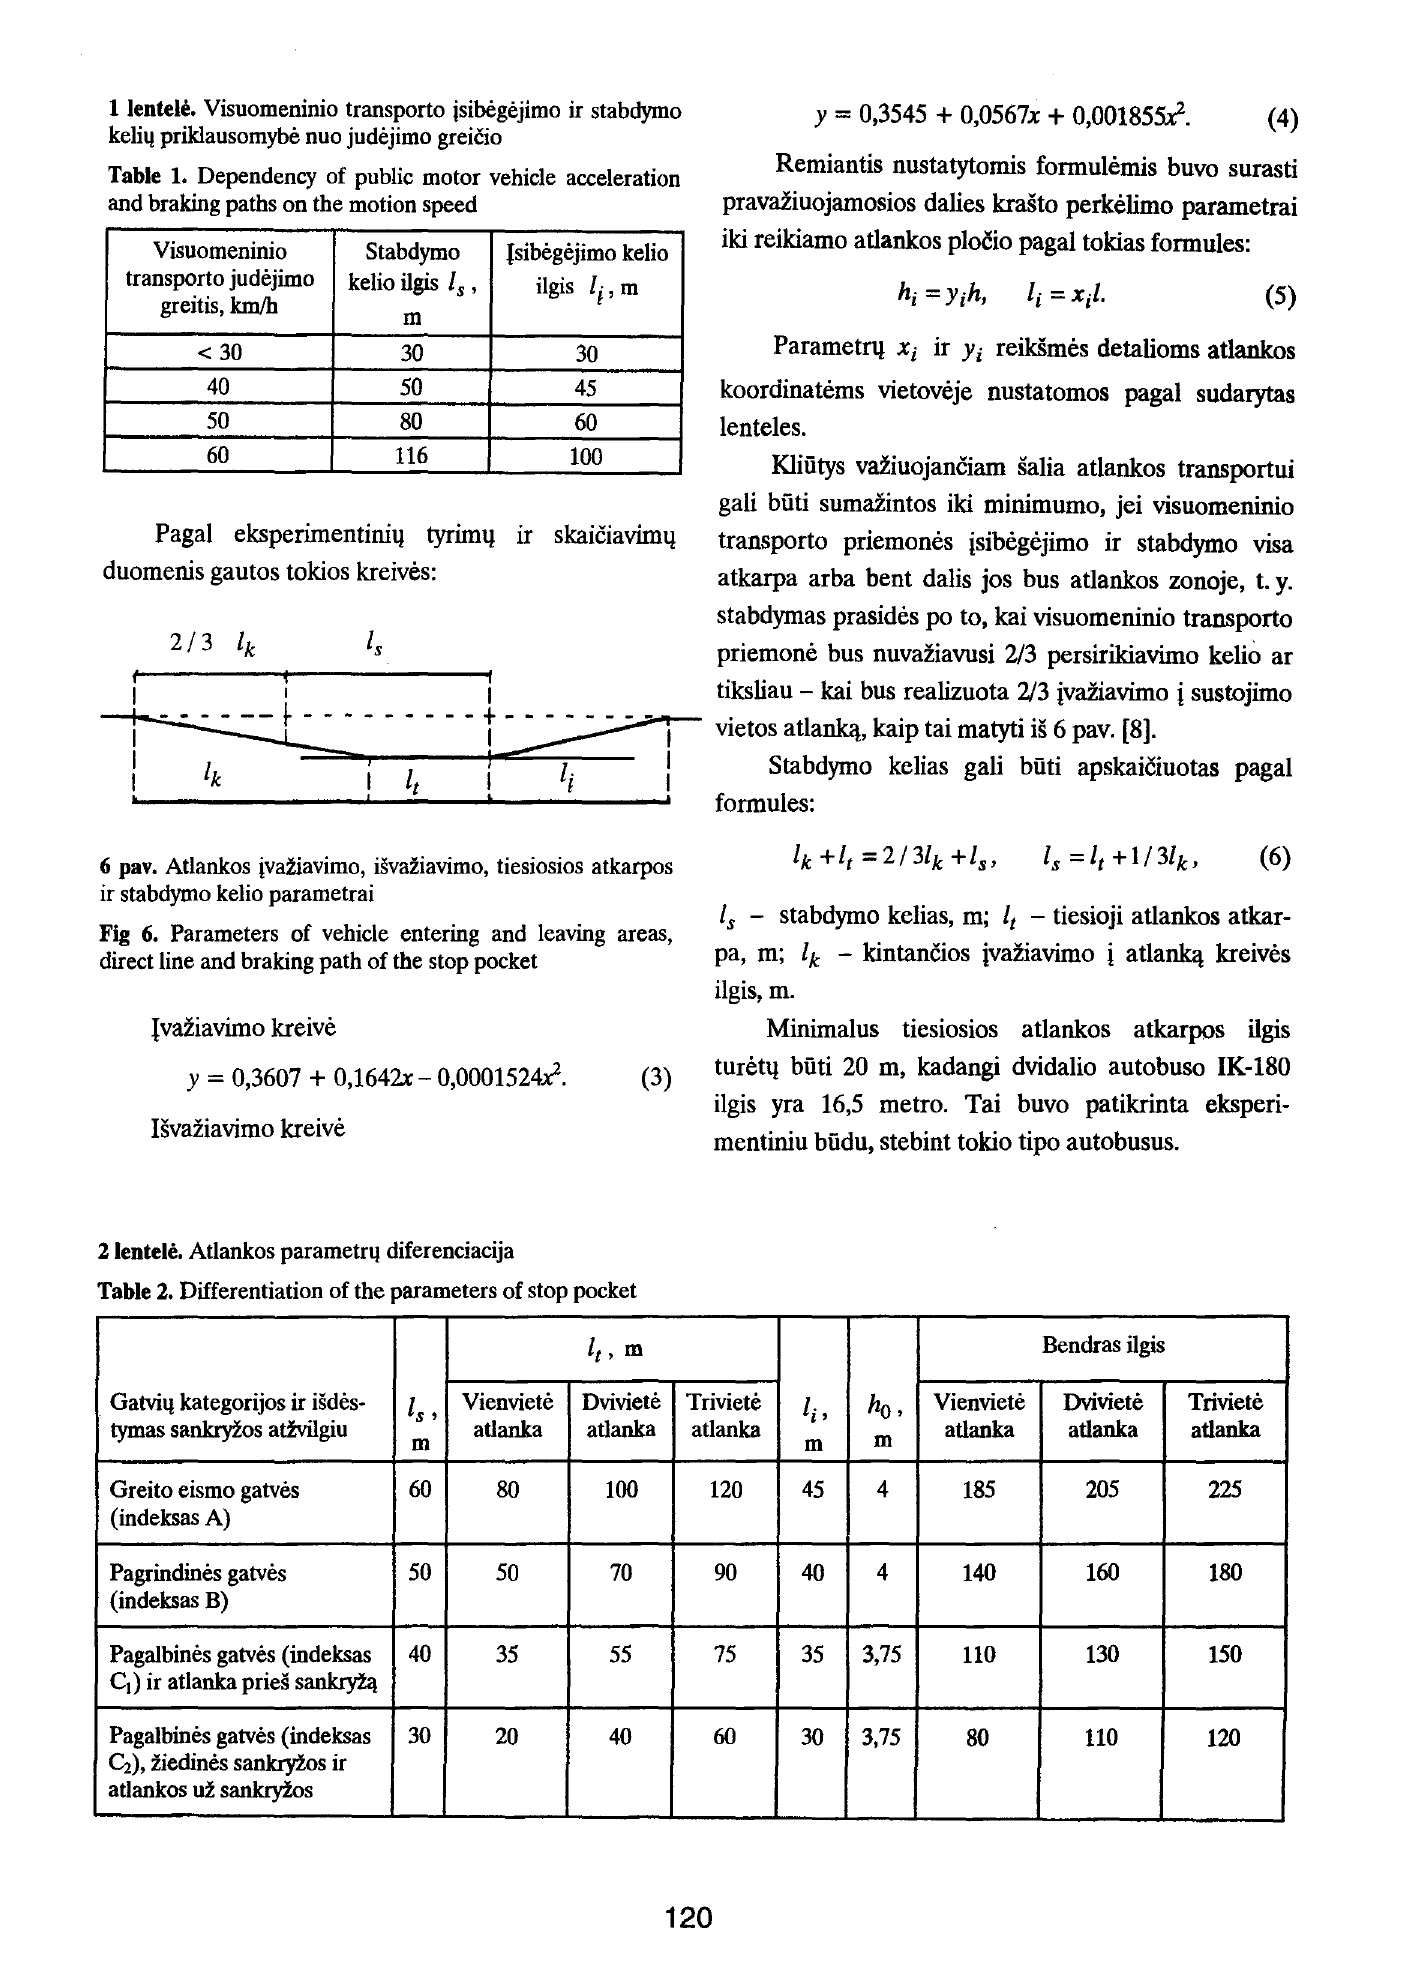
Table 1. Dependency of public motor vehicle acceleration and braking paths on the motion speed